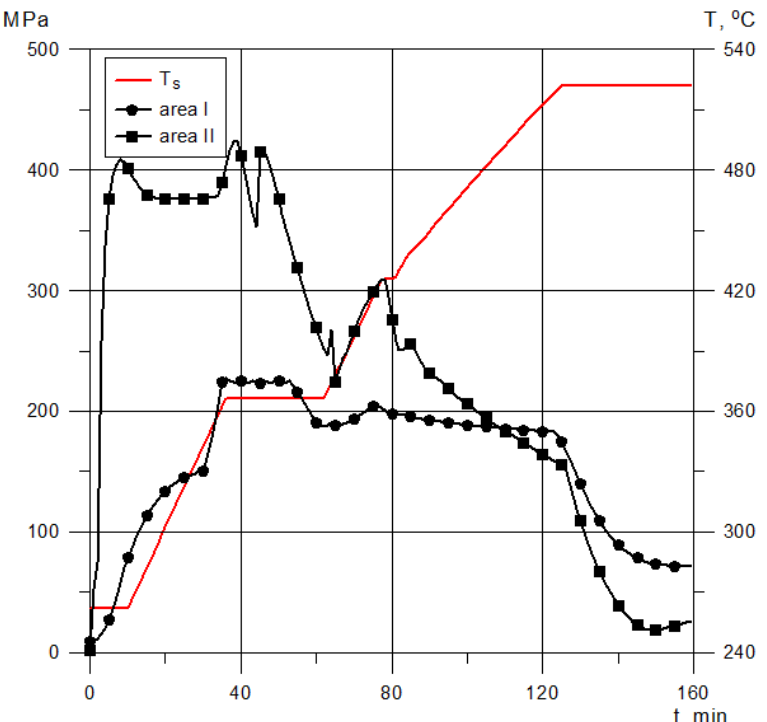
Figure 7. The course of stresses in critical areas and steam temperature after applying the stress control algorithm for 𝜎 𝑝𝑒𝑟𝐼 = 220 MPa and 𝜎 𝑝𝑒𝑟𝐼𝐼 = 420 MPa .